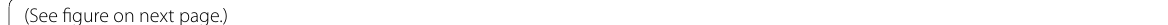
figure on next Fig. 3 Average C/N 0 at different elevation angles for GPS, GLONASS, Galileo, and BDS for GNSS receiver 1 and receiver 2. a Average C/N 0 at different elevation angles for GPS, GLONASS, Galileo, and BDS during period 1 at receiver 1 (without glass, blue line and marker) and receiver 2 (with glass, red line and marker); b average C/N 0 at different elevation angles for GPS, GLONASS, Galileo, and BDS during period 2 at receiver 1 (without glass, blue line and marker) and receiver 2 (without glass, red line and marker); c difference in average C/N 0 for GPS, GLONASS, Galileo, and BDS between two receivers at different elevation angles during period